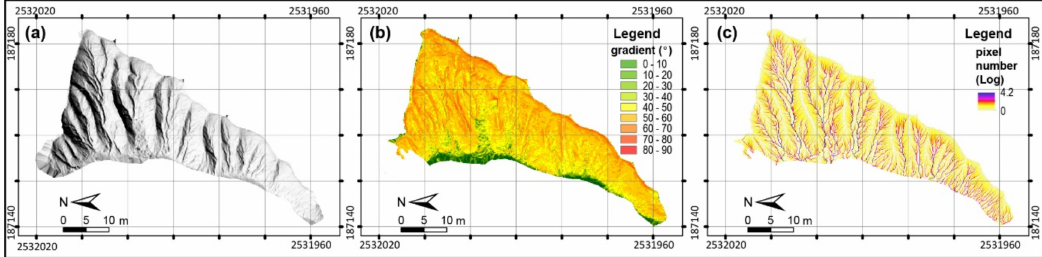
Figure 2. Study area map. The shadow-relief image of target slope ( a ), gradient image ( b ), and drainage map ( c ) created by digital elevation